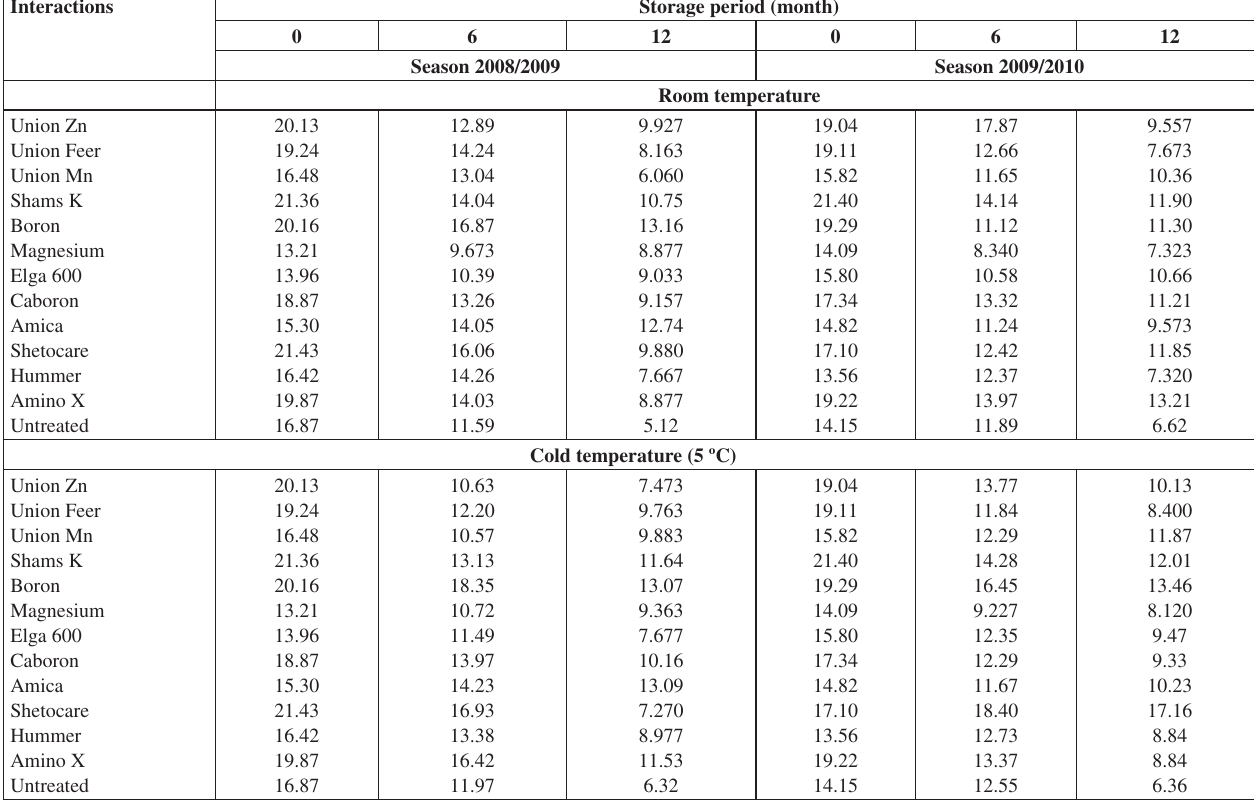
of onion seeds during two seasons